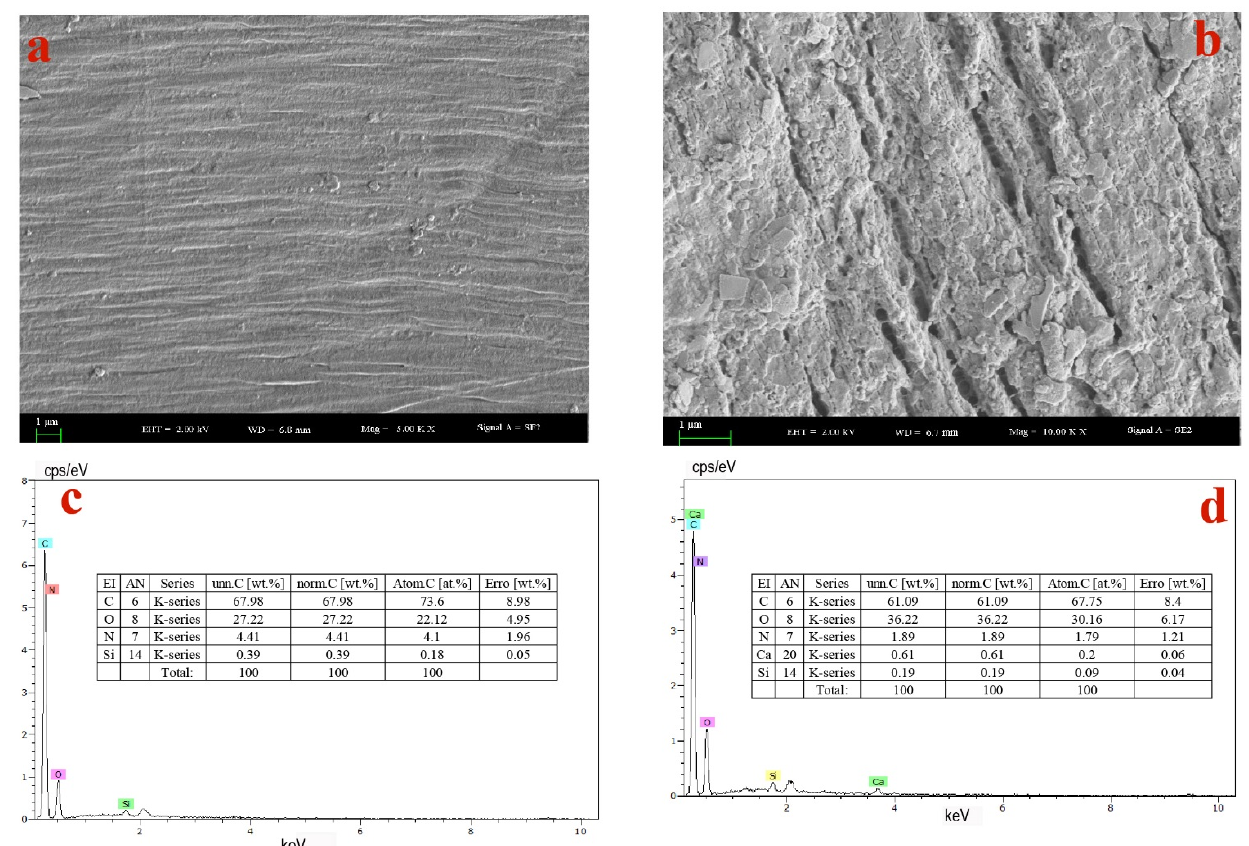
Figure 6. The trend of PBAT film degradation rate with and without inoculation of JZ1 over a period of 8 weeks.